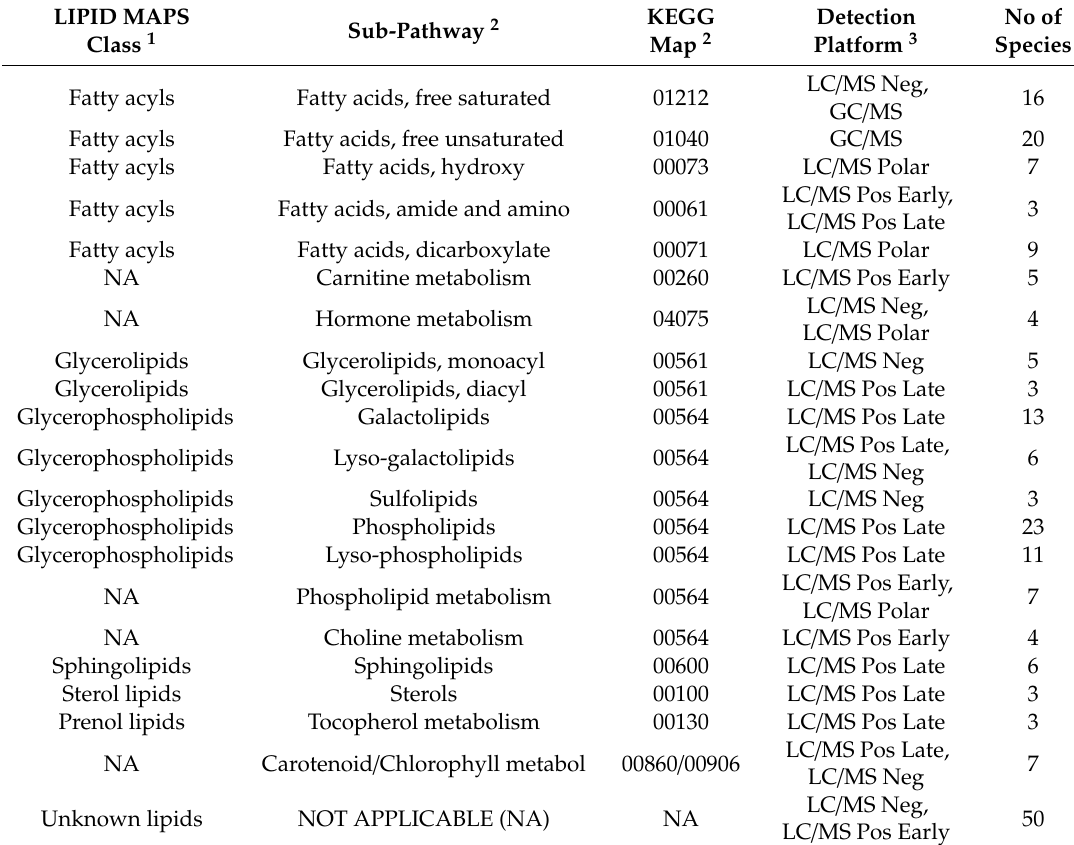
Table 1. Lipid classes, metabolic pathways, employed chromatography platform / ionization polarity, and a number of molecular species profiled in the